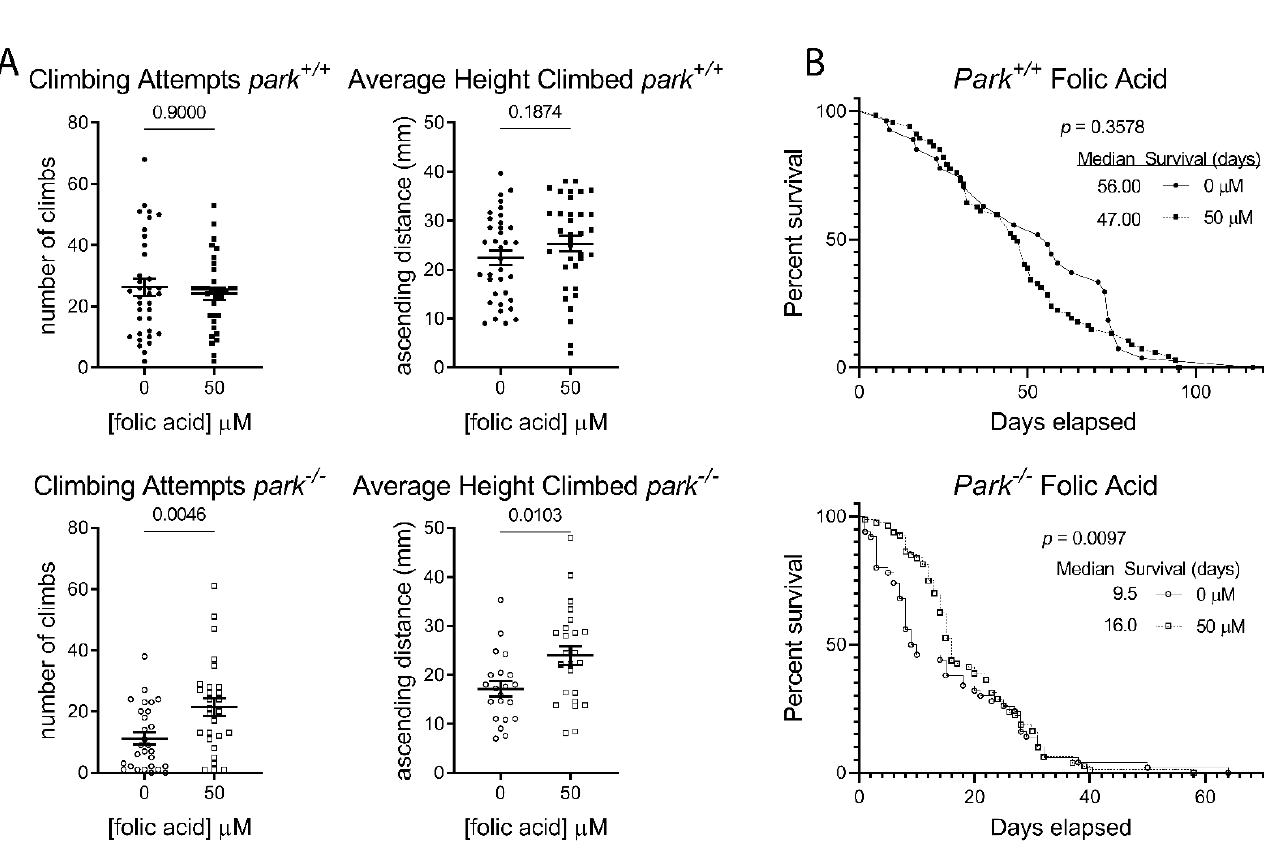
Figure 4. Folic acid administration increases parkin-null Drosophila climbing behavior and median survival. ( A ) Park −/− and park +/+ flies were raised on 50 µM folic acid and activity was recorded in the MB5 Multibeam Drosophila Activity Monitor for 20 min on day 10. Folic acid administration improved park −/− but not park +/+ climbing attempts and average height climbed. Each data point represents data from one fly ( n ≥ 21). Unpaired t tests were run to determine the effect of folic acid on climbing attempts and height climbed. ( B ) For the survival study, flies maintained on folic acid-supplemented food were monitored every 2 – 3 days, and percent surviving were reported until all flies expired ( n ≥ 47). Gehan – Breslow – Wilcoxon test was performed to determine the effect of folic acid. p values are reported for each comparison.